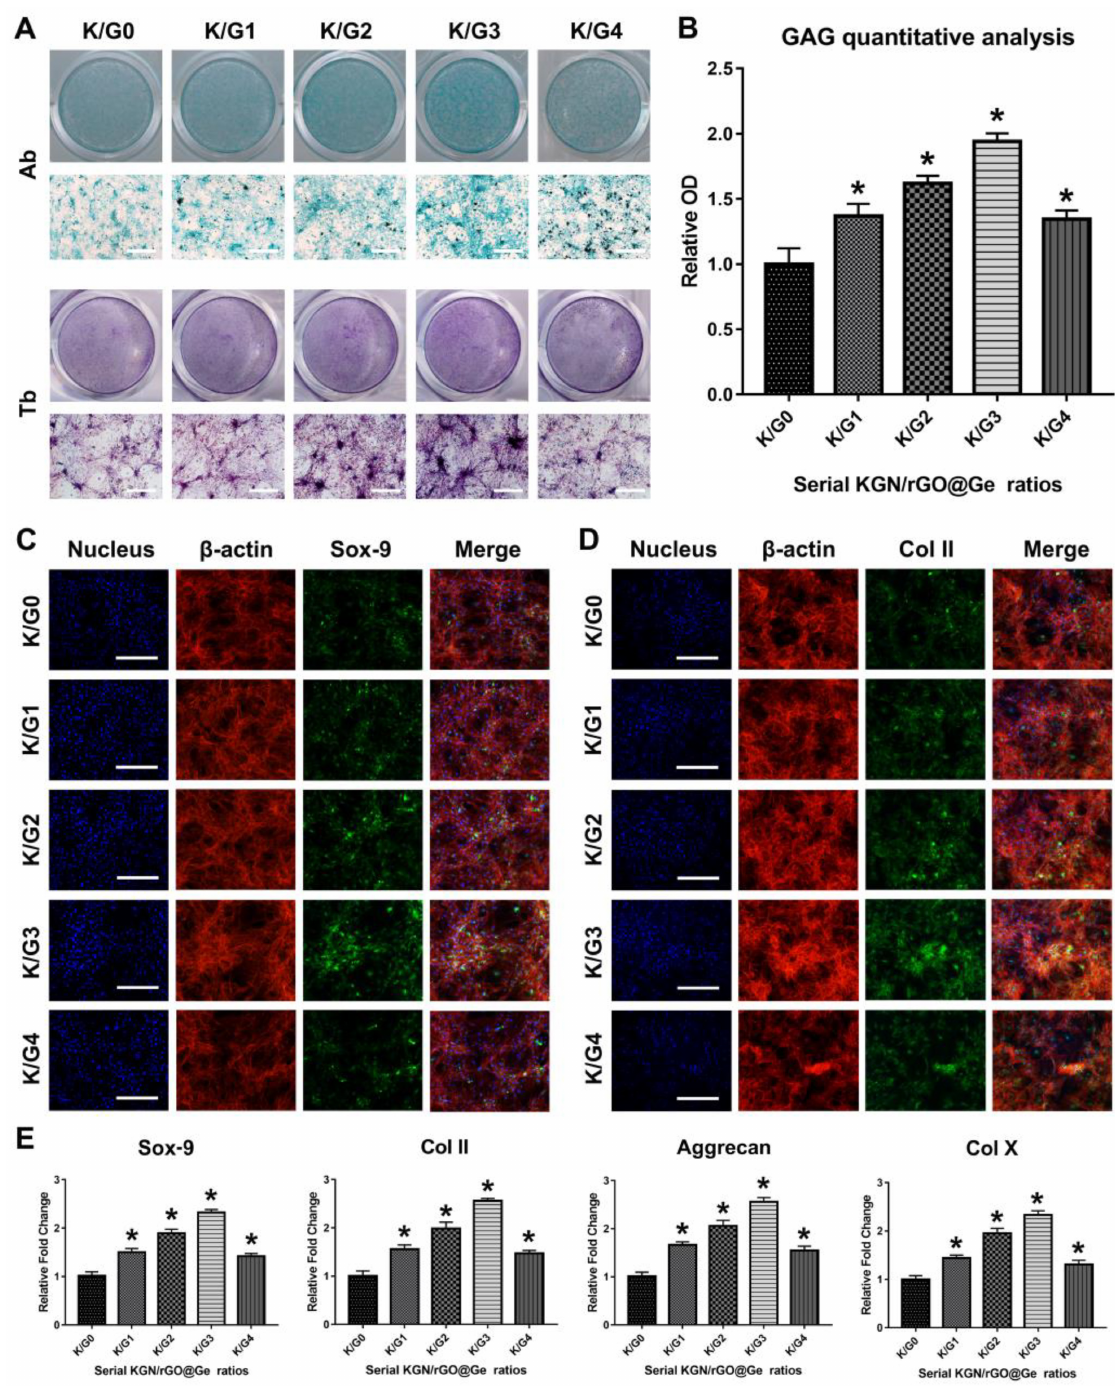
Figure 6. The chondrogenic differentiation of ADSCs induced by KGN/rGO@Ge complex media. ( A ) The evaluation of different K/G ratio media on the ADSCs chondrogenic differentiation. The Ab and Tb stainings were used to test the effects of different K/Gs (1 µ M KGN corresponding to 0, 10, 10 2 , 10 3 and 10 4 µ g/mL rGO@Ge) medium, bar: 500 µ m. ( B ) The quantitative analysis of the alcian blue staining to evaluate the GAG content. * p < 0.05 indicates a significant difference compared to the K/G0 group. Immunofluorescence staining of the chondrogenic differentiation marker Sox-9 ( C ) and Col II ( D ) to clarify the ADSCs chondrogenesis, Bar: 200 µ m. ( E ) The PCR analysis on the expression of the chondrogenic differentiation markers in ADSCs cultured with the different K/G media. * p < 0.05 indicates a significant difference compared to the K/G0 group.